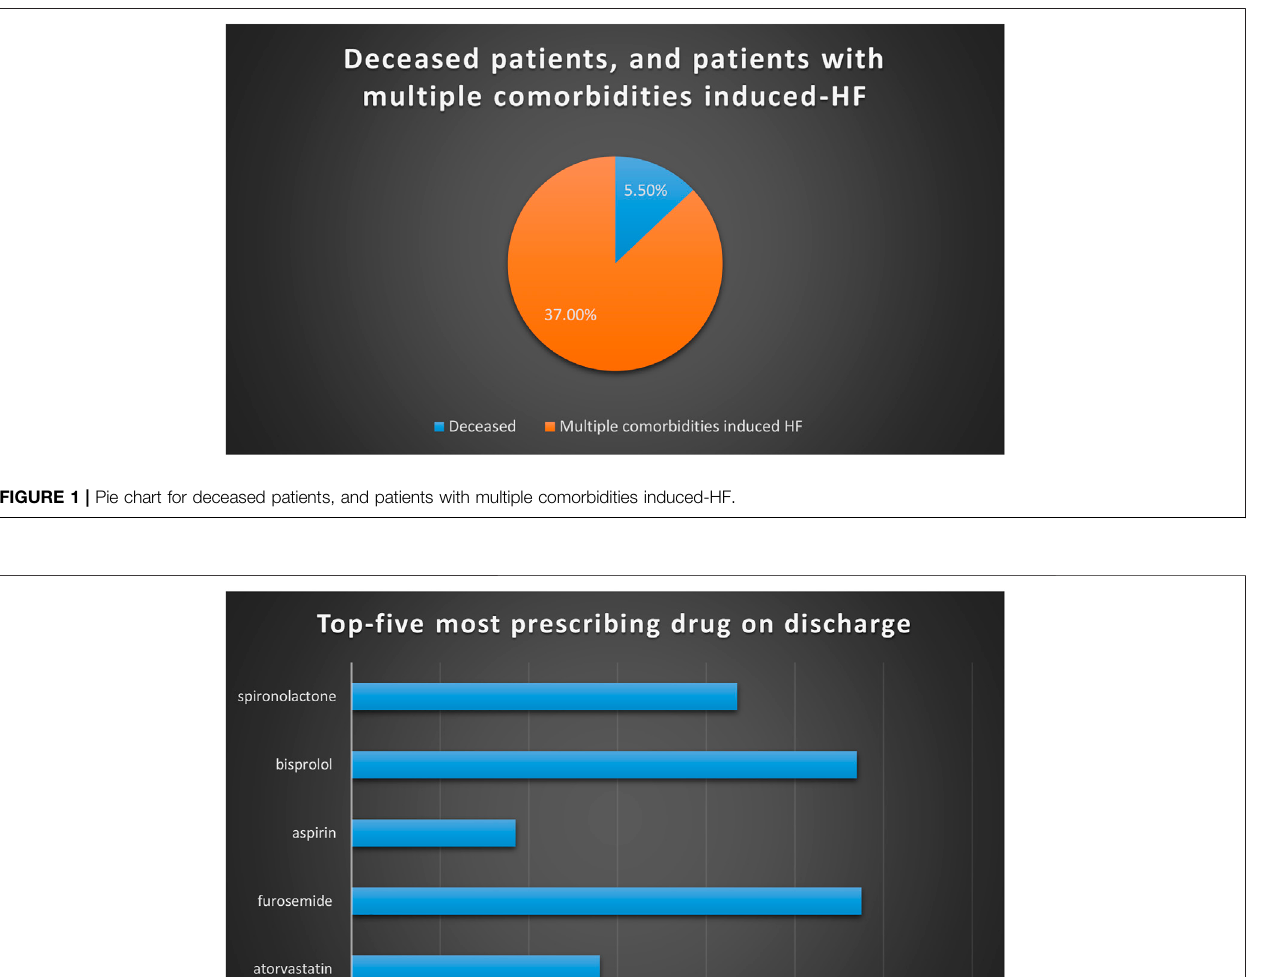
Frontiers in Pharmacology |